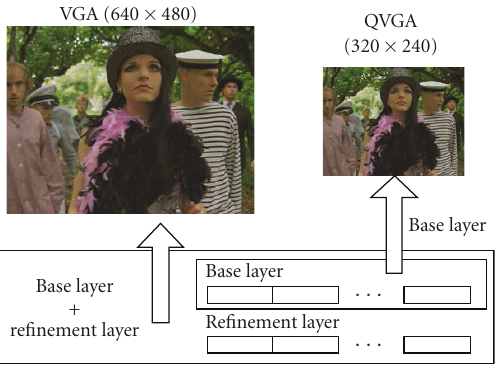
Figure 14: The H.264 scalable encoded video composes of two embedded resolutions.